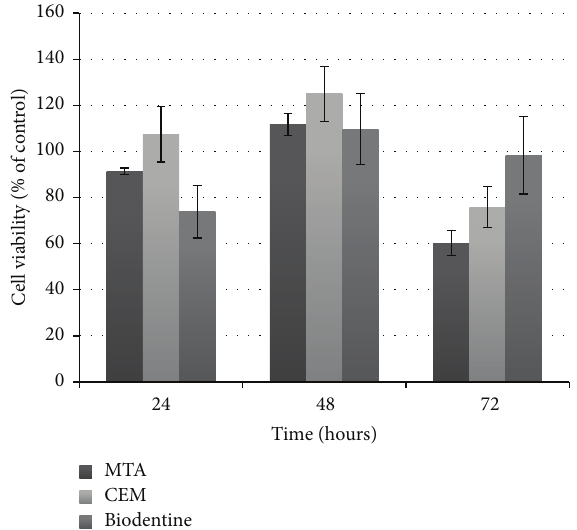
Figure 2: Cell viability of cultured human periodontal ligament fibroblasts after incubation with the tested materials for 24, 48, and 72 hours. Each bar represents the mean absorbance ± standard